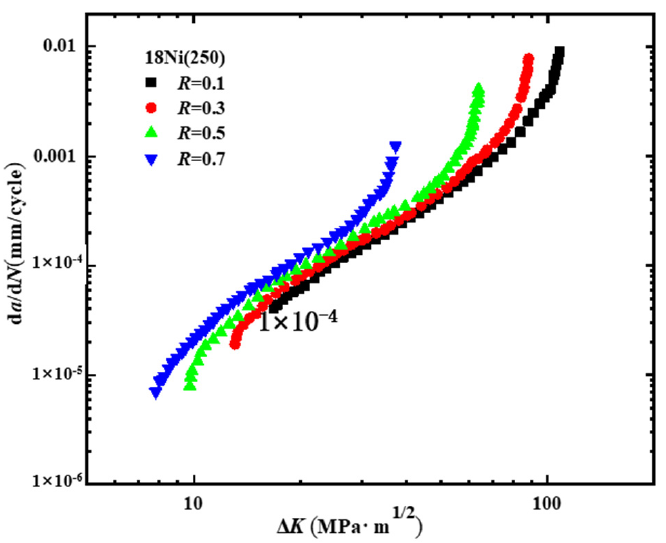
Figure 2. The 18Ni (250) fatigue crack growth rate